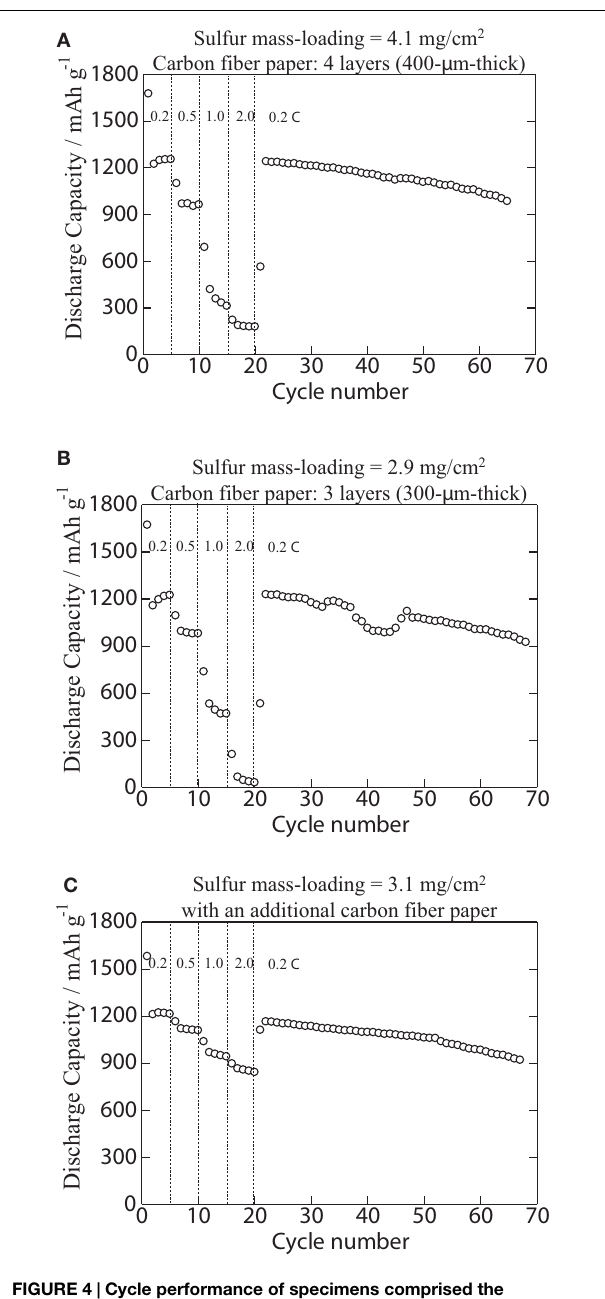
FIGURE 4 | Cycle performance of specimens comprised the S/PAN/KB-based cathodes with (A) a cathode composite mass-loading of 11mg/cm 2 (sulfur, 4.1mg/cm 2 ; carbon fiber paper, 400 µ m thick), (B) a cathode composite mass-loading of 7.7mg/cm 2 (sulfur, 2.9mg/cm 2 ; carbon fiber paper, 300 µ m thick), and (C) a cathode composite mass-loading of 8.1mg/cm 2 (sulfur, 3.1mg/cm 2 ; carbon fiber paper, 400 µ m thick) with a 100- µ m-thick additional carbon fiber paper inserted between a current-collecting coin